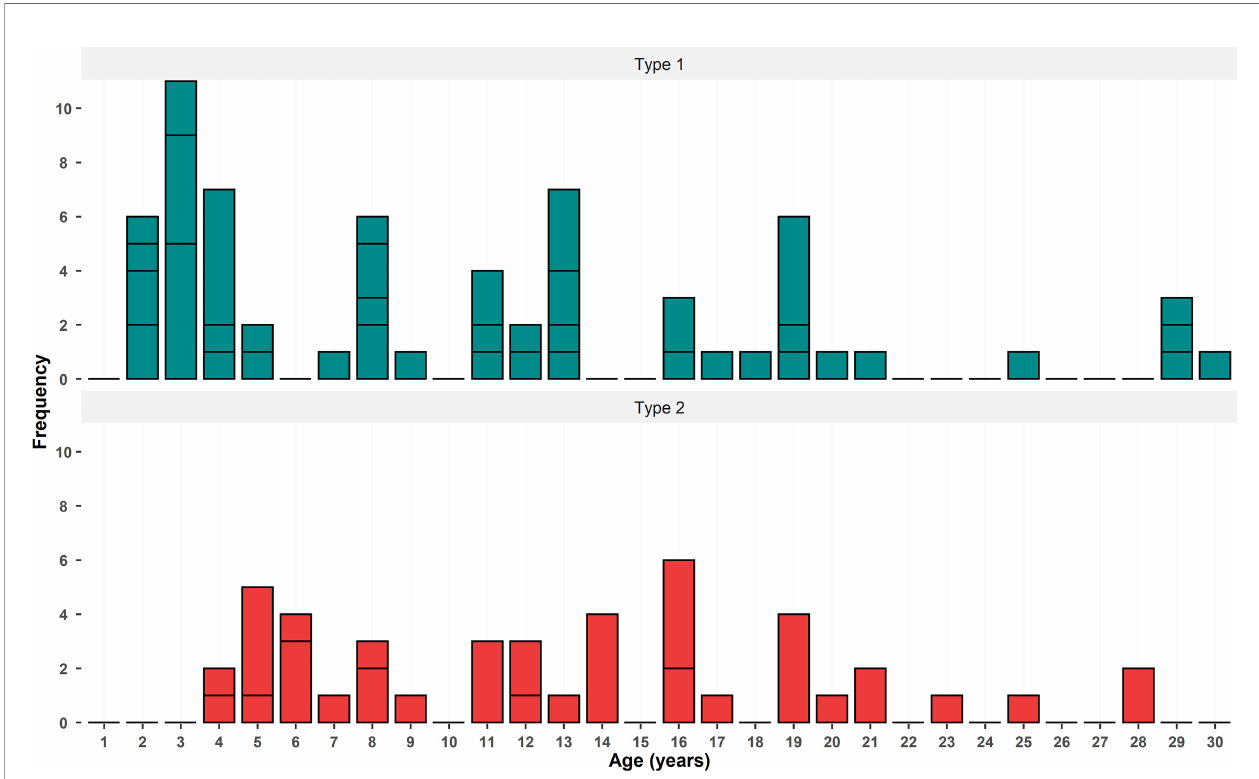
FIGURE 7 | Age distributions for the two morphotypes of Sotalia spp. dolphin teeth detected in the trade of handcrafted objects in the North and Northeast regions of Brazil. Branches indicated the frequency of each age class in the handicraft